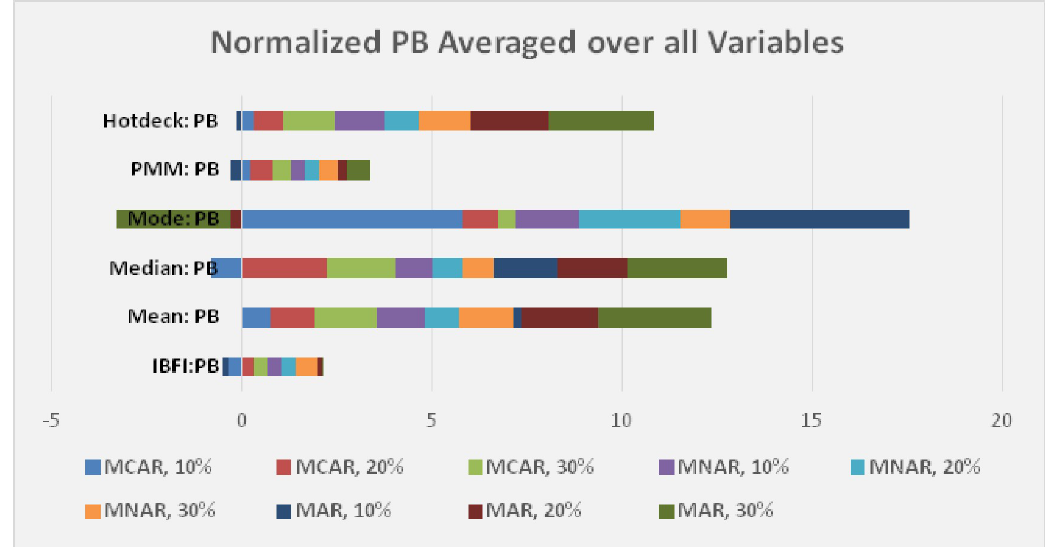
Fig 6. Statistics for IBFI compared with other methods (mean, median, mode, PMM, Hotdeck) normalized to the average statistic for all methods averaged across different variables, showing PB for 10%, 20%, and 30% MCAR, MNAR, and MAR